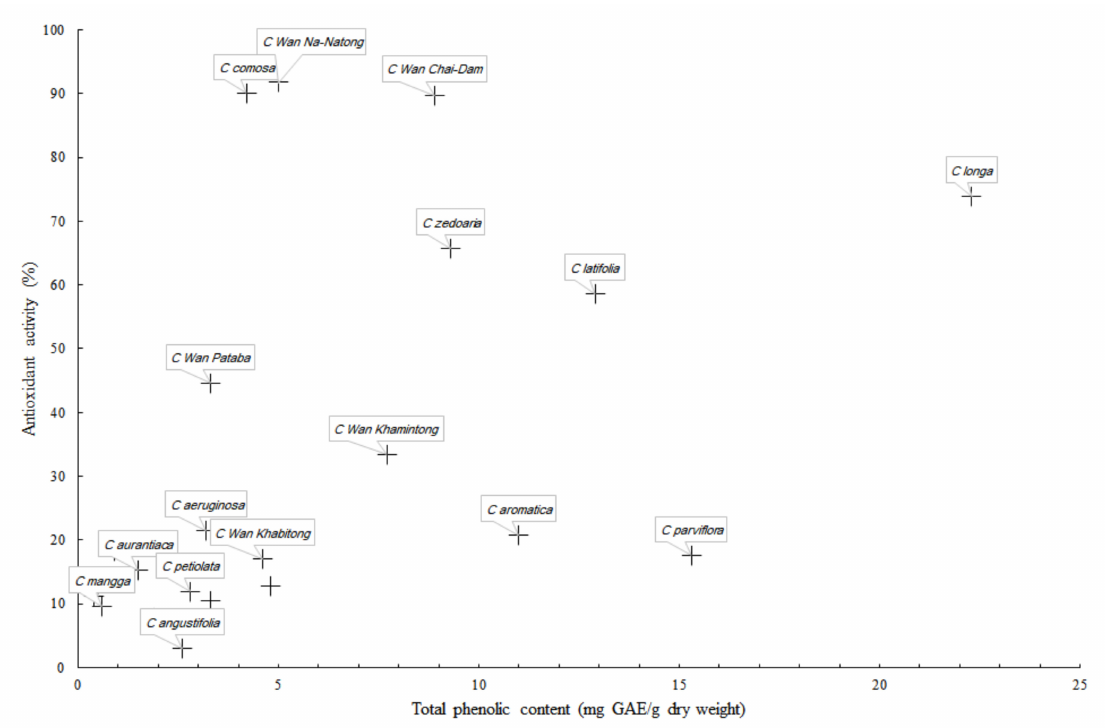
Figure 2. Correlation chart of total phenolic content and DPPH radical scavenging antioxidant activity. The data are from Table 2, and only notable data are labeled in the